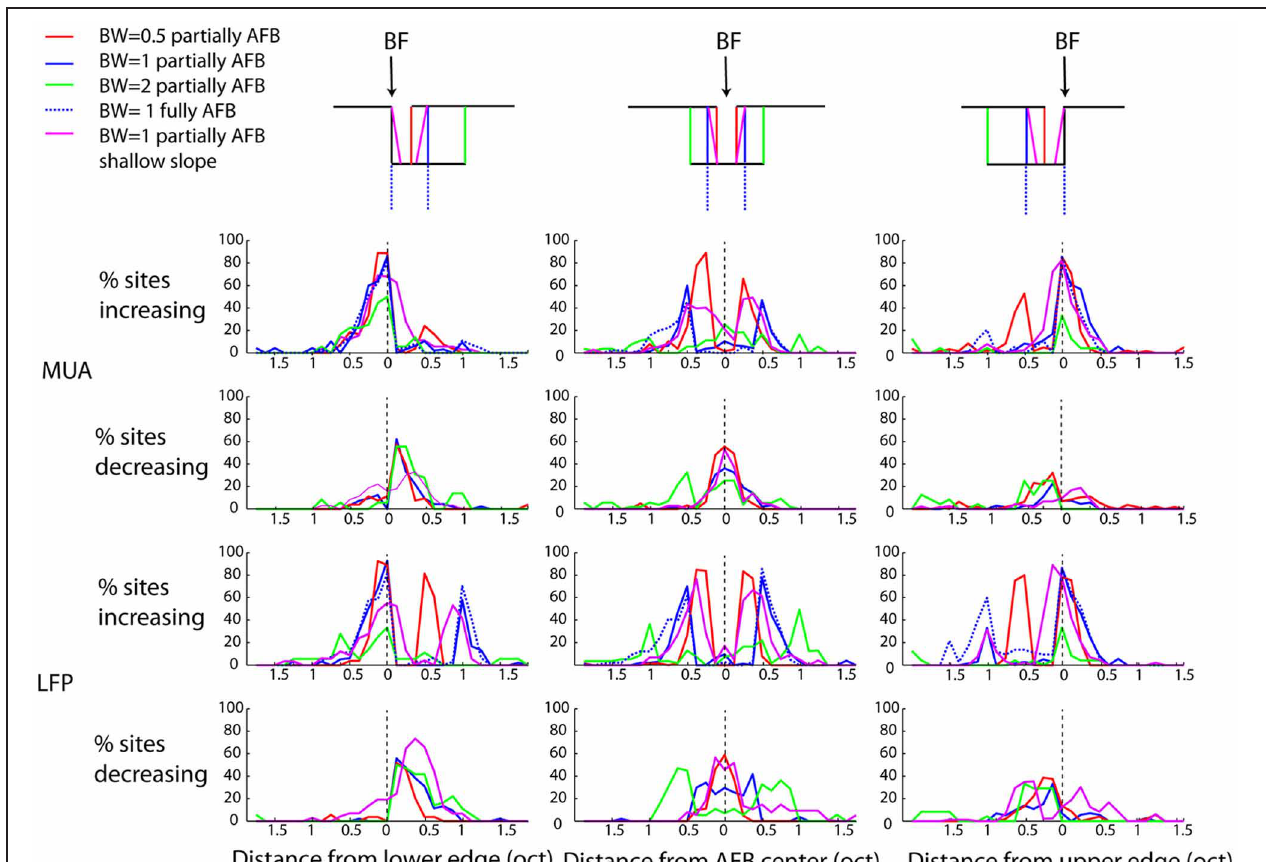
FIGURE 6 | Percentage of sites showing an increased response (first and third rows, for MUA and LFPs, respectively), or a decreased response (second and fourth rows, for MUA and LFPs, respectively). Otherwise as Figure 4 . Nearly 90% of sites showed an increased response at both edges